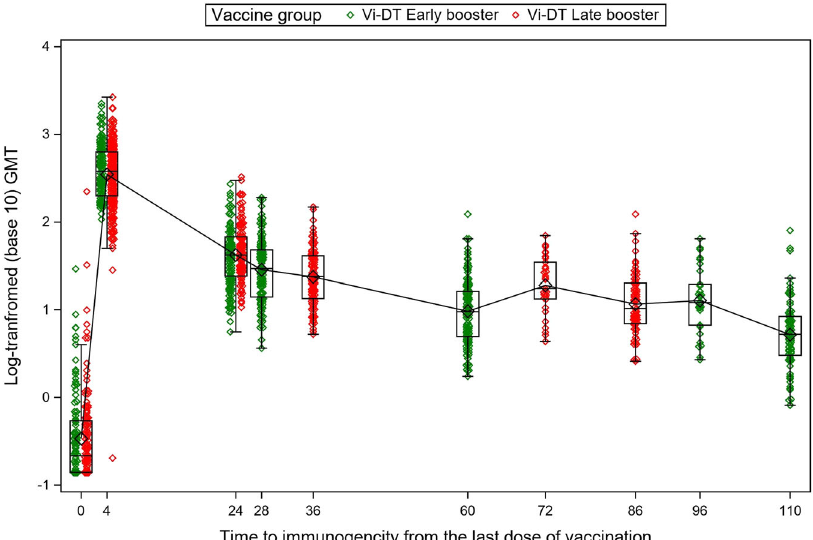
Fig. 4 Geometric mean titers presented by time from the last dose of Vi-DT in late- and early booster groups receiving the Vi-DT vaccine among infants and toddlers. The x axis represents the duration between the last dose of vaccination and each immunogenicity timepoint, while the y axis represents the log 10 -transformed geometric mean titer (GMT) levels. For the late-booster group, the durations on the x axis represent the duration between the fi rst dose and the immunogenicity timepoint; for the early booster group, the duration refers to the time between the fi rst dose and immunogenicity timepoint for the 4-week and 24-week timepoints, while for 28, 60, 96, and 110, this represents the duration between the second dose and the immunogenicity